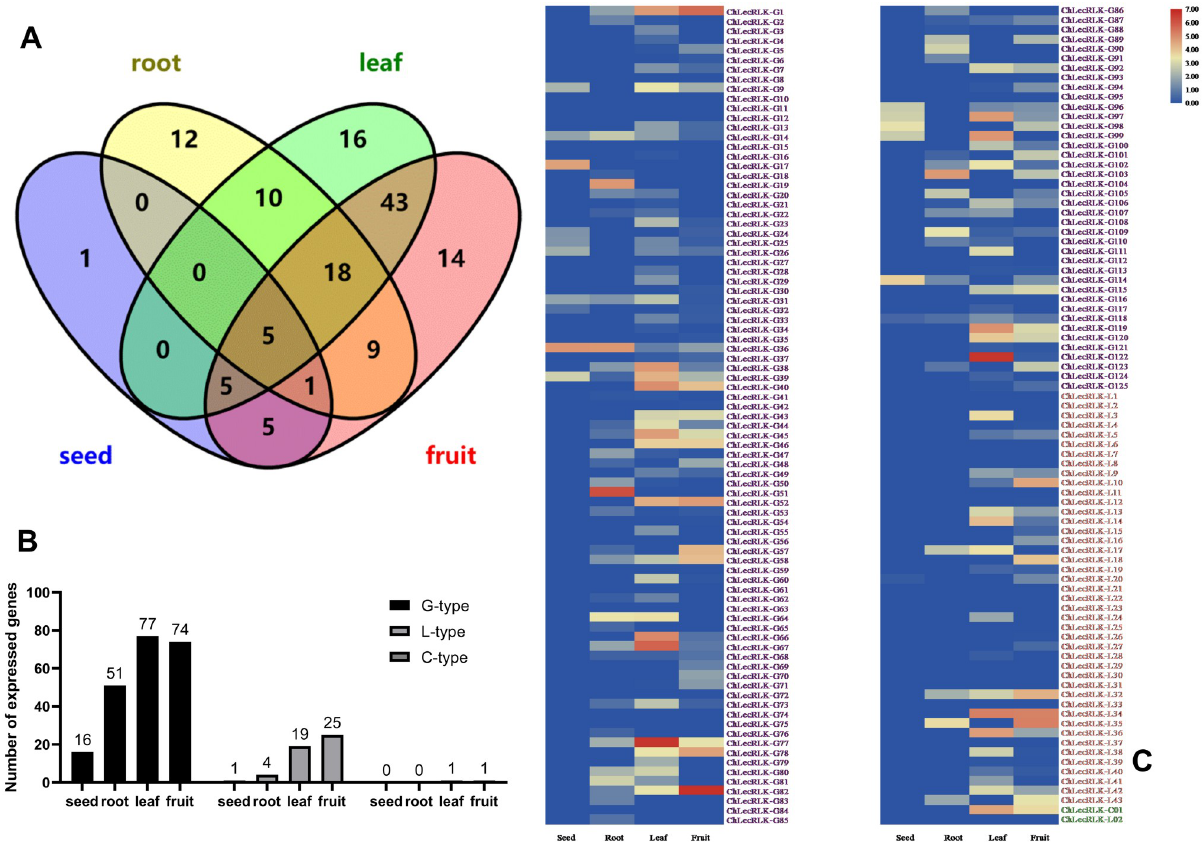
Fig 4. Venn diagram (A), classification (B) and expression (C) of chLecRLKs in different tissues of C . humilis . Names of G-type genes were listed in purple, names of L-type genes were listed in red, and names of C-type genes were listed in green.